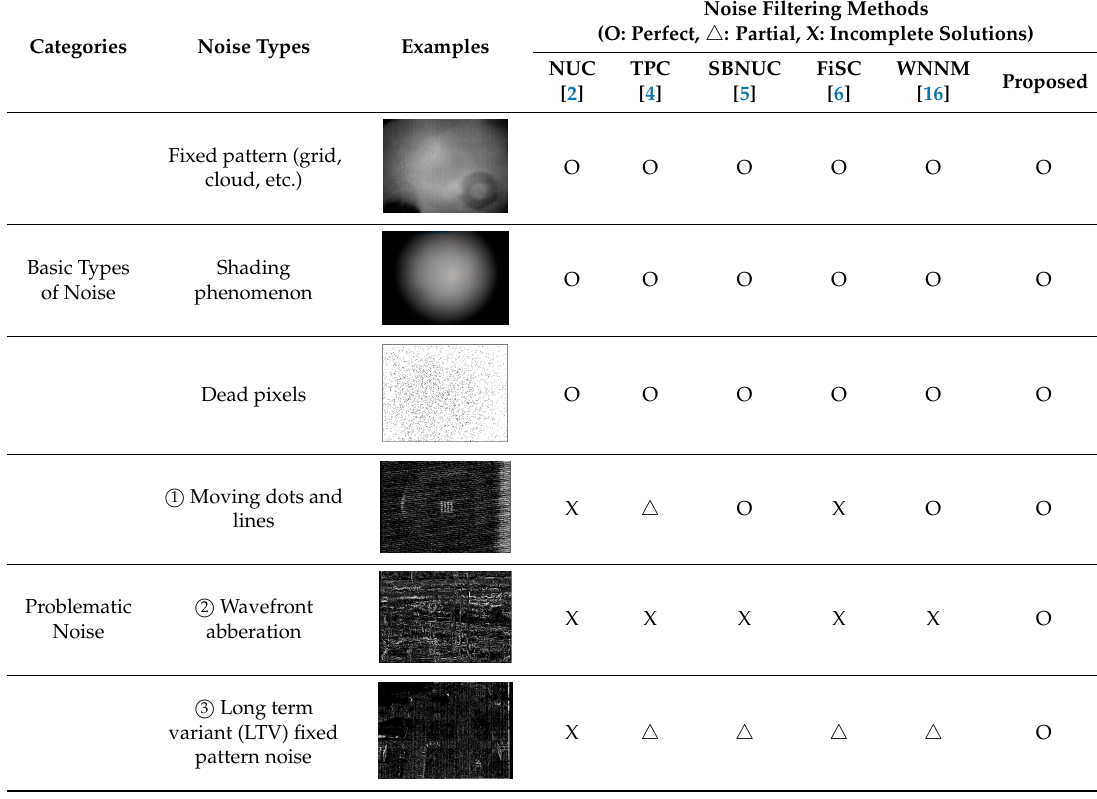
Figure 2. Block diagrams of the conventional NUC method.